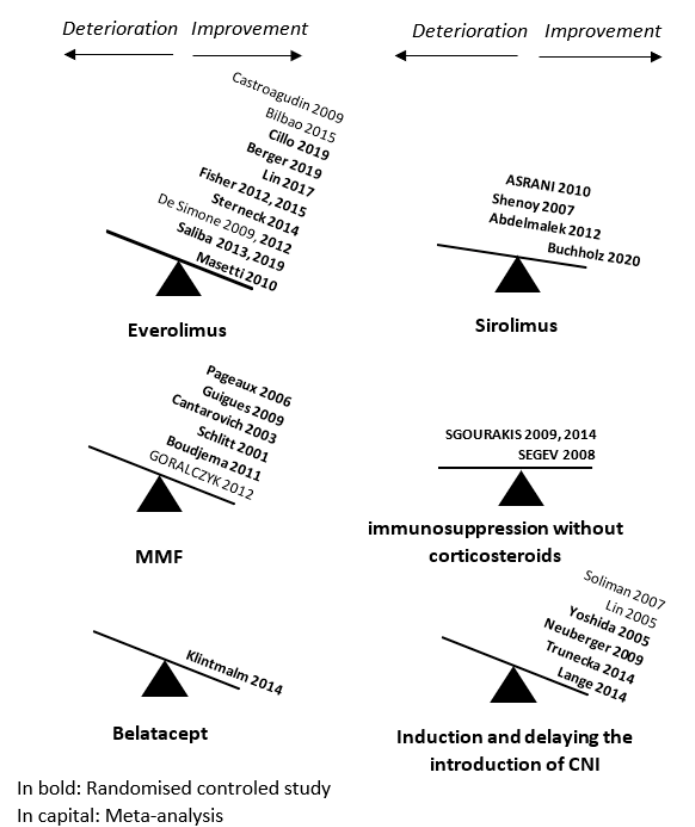
Figure 2. Review of the main studies on possible immunosuppressive regimens in liver transplanta- tion and their effects on kidney function compared to standard immunosuppressive therapy. MMF: mycophenolate mofetil; CNI: calcineurin